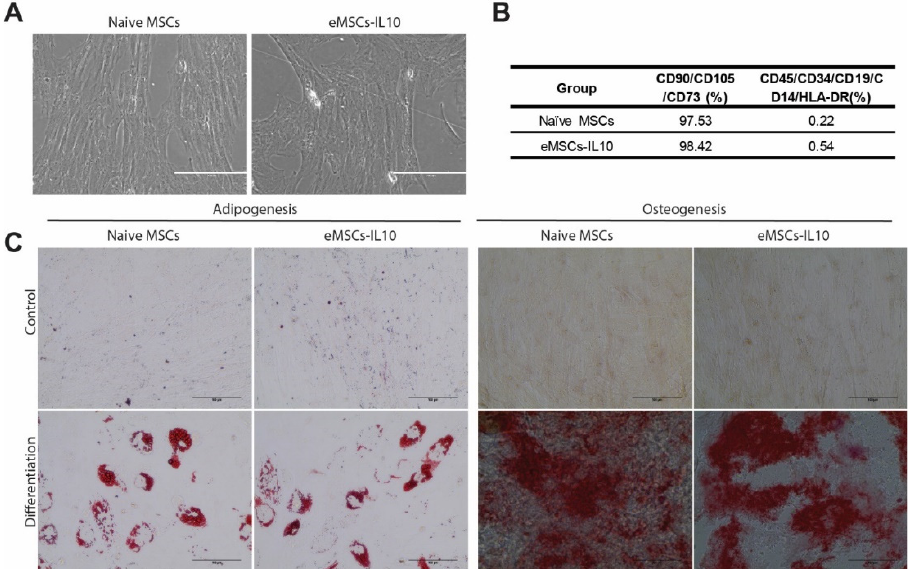
Figure 2. Characterization of naïve MSCs and eMSCs-IL10. ( A ) Representative images of naïve MSCs and eMSCs-IL10. Both naïve MSCs and eMSCs-IL10 displayed spindle or fibroblast-like morphology (scale bar: 200 µ m). ( B ) Summary table showing MSC surface markers. Both naïve MSCs and eMSCs-IL10 were positive for cell surface markers CD90, CD105, and CD73 (>95%) and negative for molecules CD45, CD34, CD19, CD14, and HLA-DR (<5%). ( C ) Representative images of adipogenic and osteogenic differentiation of MSCs. Adipogenesis was demonstrated by oil red-O stain with distinct lipid vacuoles. Osteogenesis was exhibited by alizarin red S staining with mineral deposition (scale bar: 100 µ m).